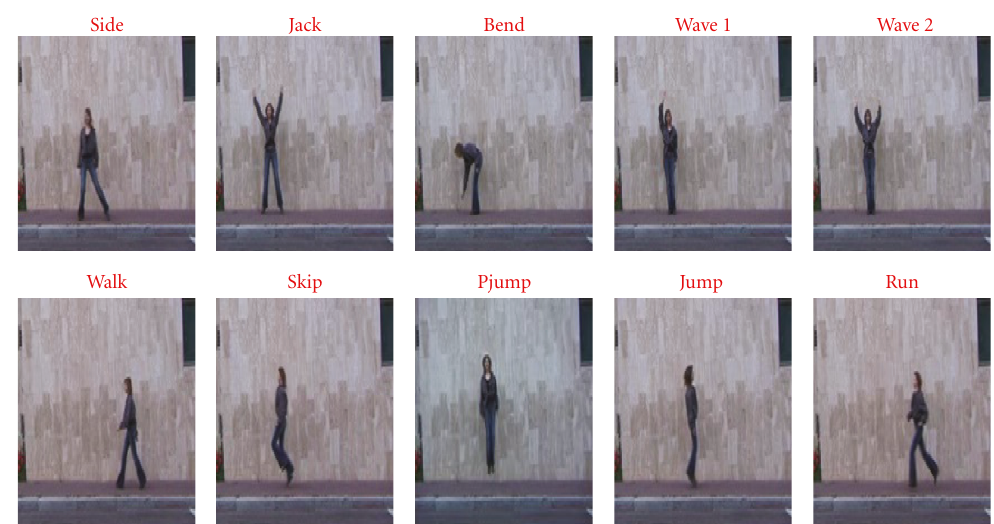
Figure 6: Sample sequences from the Weizmann action dataset.